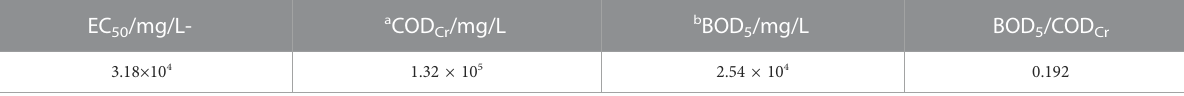
TABLE 8 Evaluation of the environmental performance of the biomimetic wellbore-strengthening PDF. EC 50